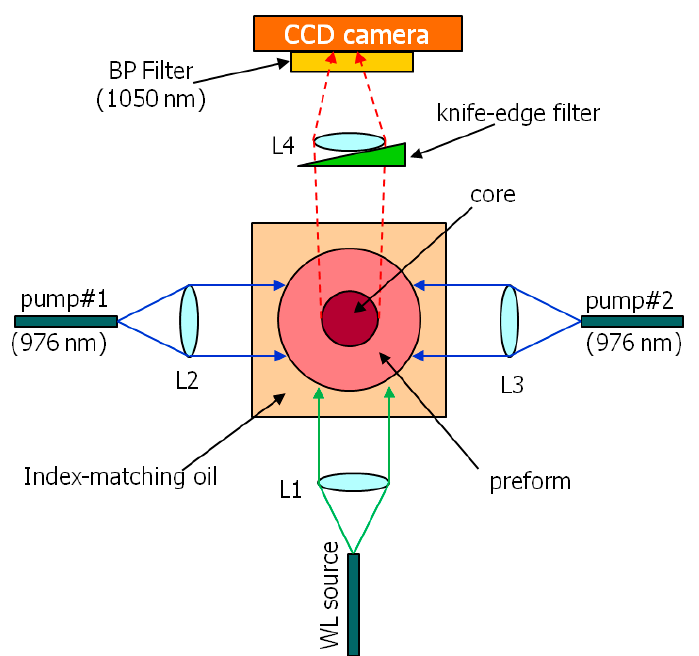
Figure 1. Experimental setup for combined profiling of refractive index (vertical arm) and active-ion (horizontal arm) profiles of optical preforms. (BP = band-pass, L = lens, WL = white light).